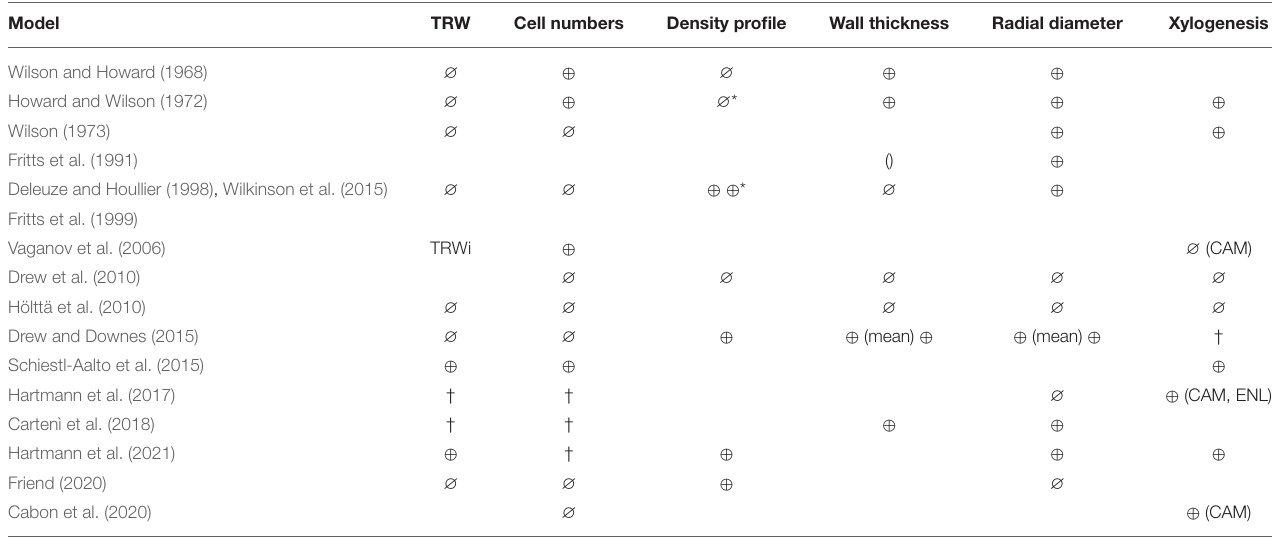
TABLE 2 | ⊕ model output compared against observations, ∅ (possible) output but not compared against observations. † Possible output but not reported. () model output, but created using an empirical relationship with previously modeled outputs. *Microdensity profile derived from wall thickness. Wilkinson et al. (2015) used the model by Deleuze and Houllier (1998), to simulate wall thickness rather than mass increase and could therefore resolve and compare against microdensity (see second ⊕∗ ). CAM, cambial cells; ENL, enlarging cells. Note that being able to resolve xylogenesis, enables phenological events (e.g., start of CAM, Start /end of ENL, etc). Note that some models display output, which are not listed here, eg. maximum density, mean density, microfibril angle. Anatomical output related to wall thickness can be expressed in cell position (Hölttä et al., 2010) or as proportion of annual ring (%) (Drew and Downes, 2015), which is not distinguished in this table. Radial diameter can refer to either cell or lumen radial diameter. Tree ring width is equivalent to the end-of season value of cumulative radial growth, measured as cumulative cell anatomy properties or directly as ring width. Cell numbers is equivalent to end of season cumulative tracheid production. Xylogenesis refers to cell numbers or cell production rates derived from xylogenesis observations. TRWi, Tree ring width